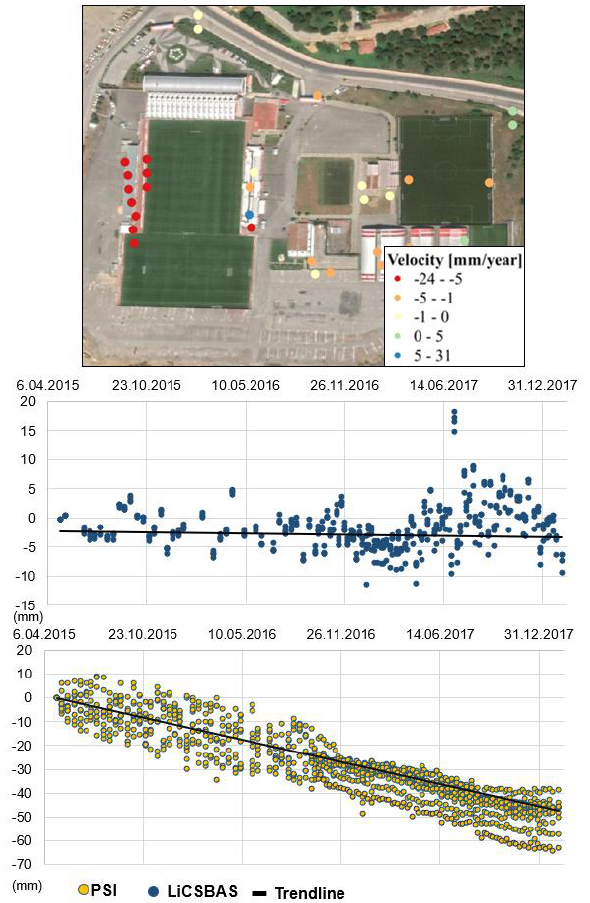
Figure 6. An example for important area (A) with time series of the PSI and LiCSBAS method. The LOS time series is from the area shown by the red